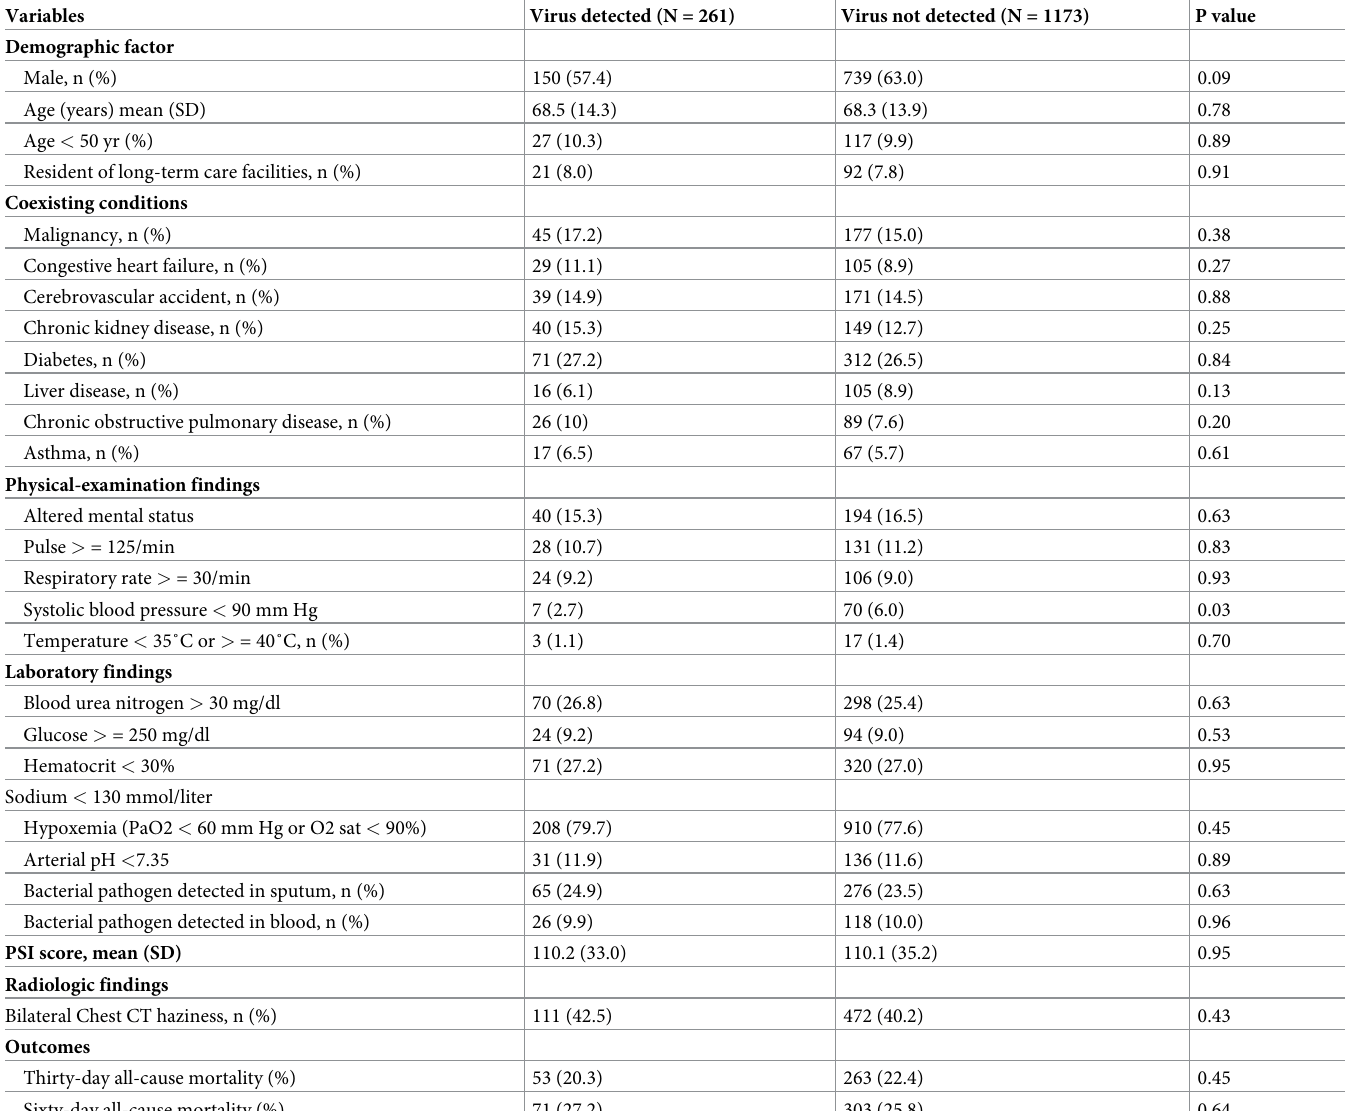
Table 1. Baseline characteristics.